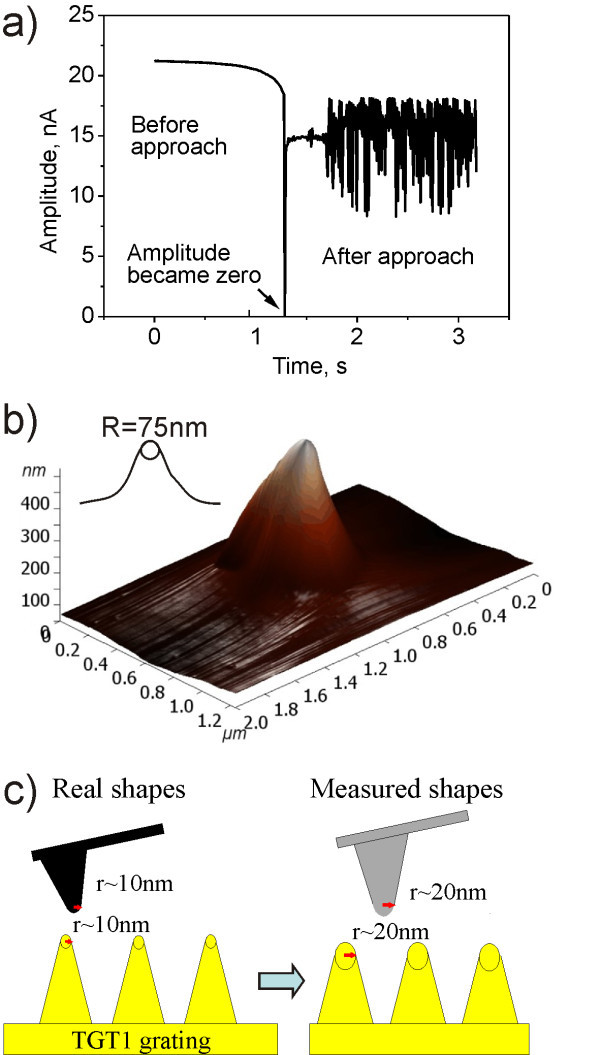
Tip shape measured after approach to the surface. (a) Approach curve in TM at Ntegra AFM (NT-MDT) in solution shows that during the first contact amplitude of oscillation A became zero. After few seconds the piezotube oscillations cause generations of the amplitude. (b) The Multi75Al tip shape, measured using TGT1 grating. (c) The model illustrates that the measured tip shape is convolution of a real tip shape and grating profile.